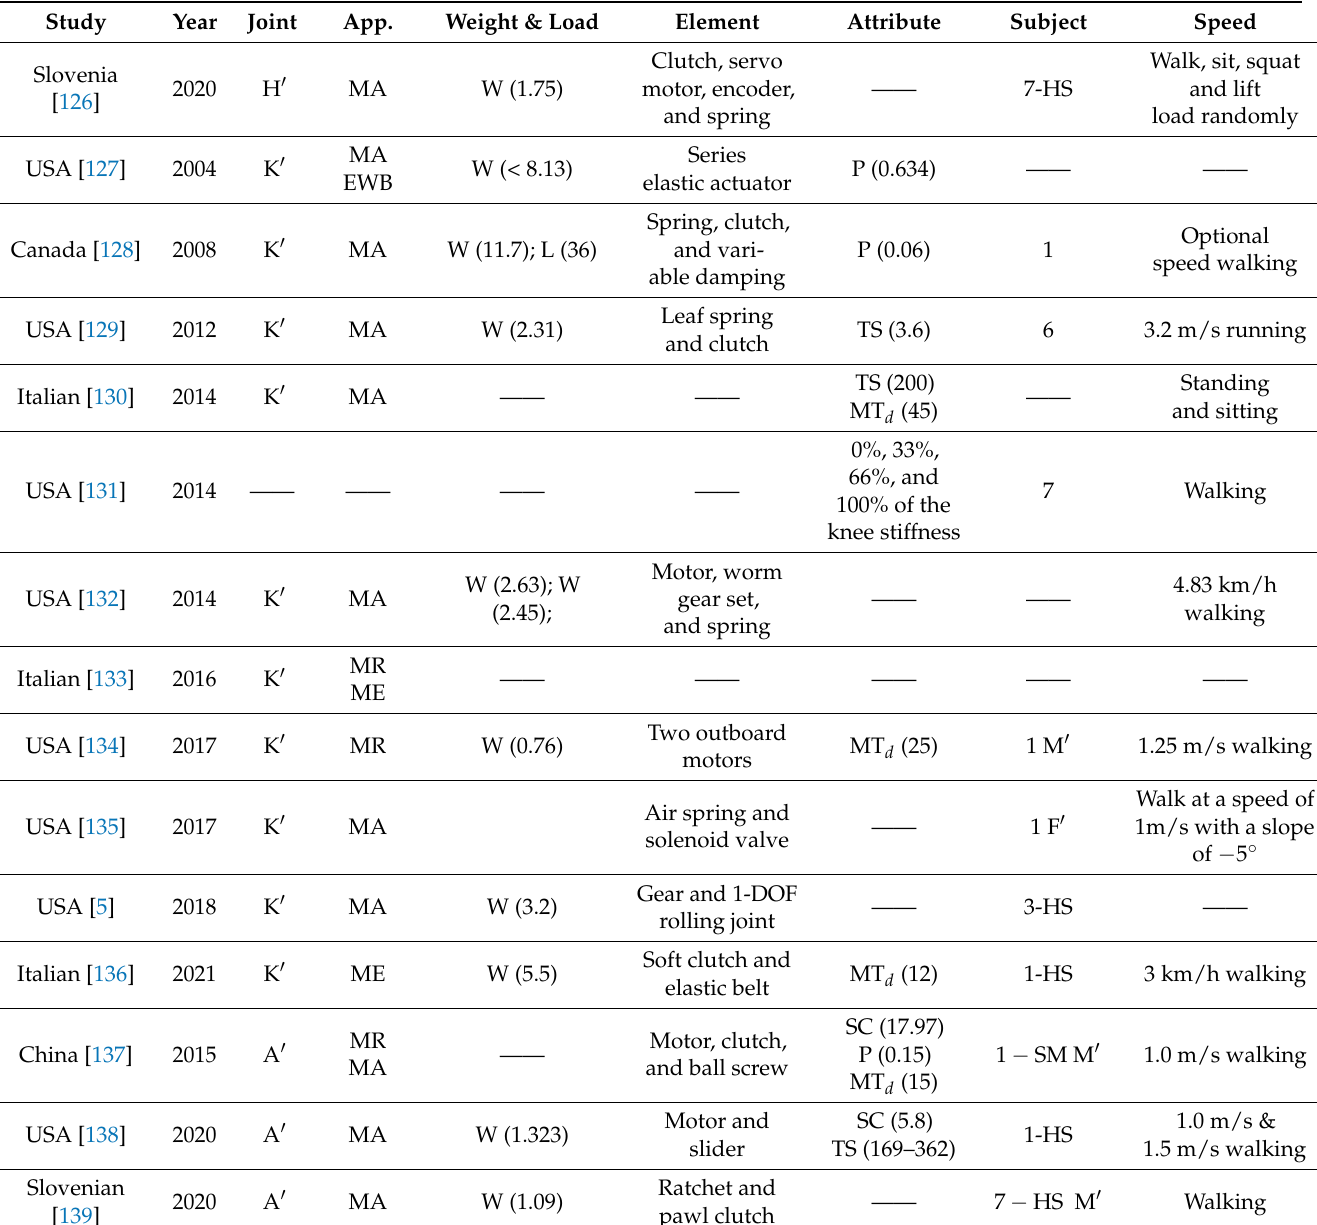
Table 7. Quasi-passive single-joint assisted lower limb